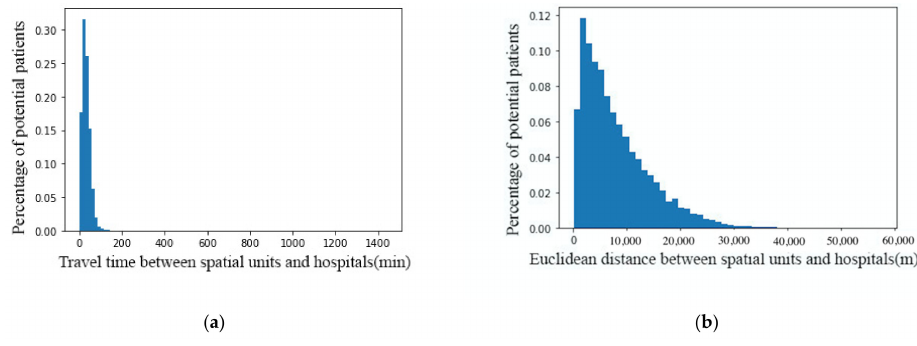
Figure 7. The relationship between potential patients and ( a ) travel costs and ( b ) travel time.